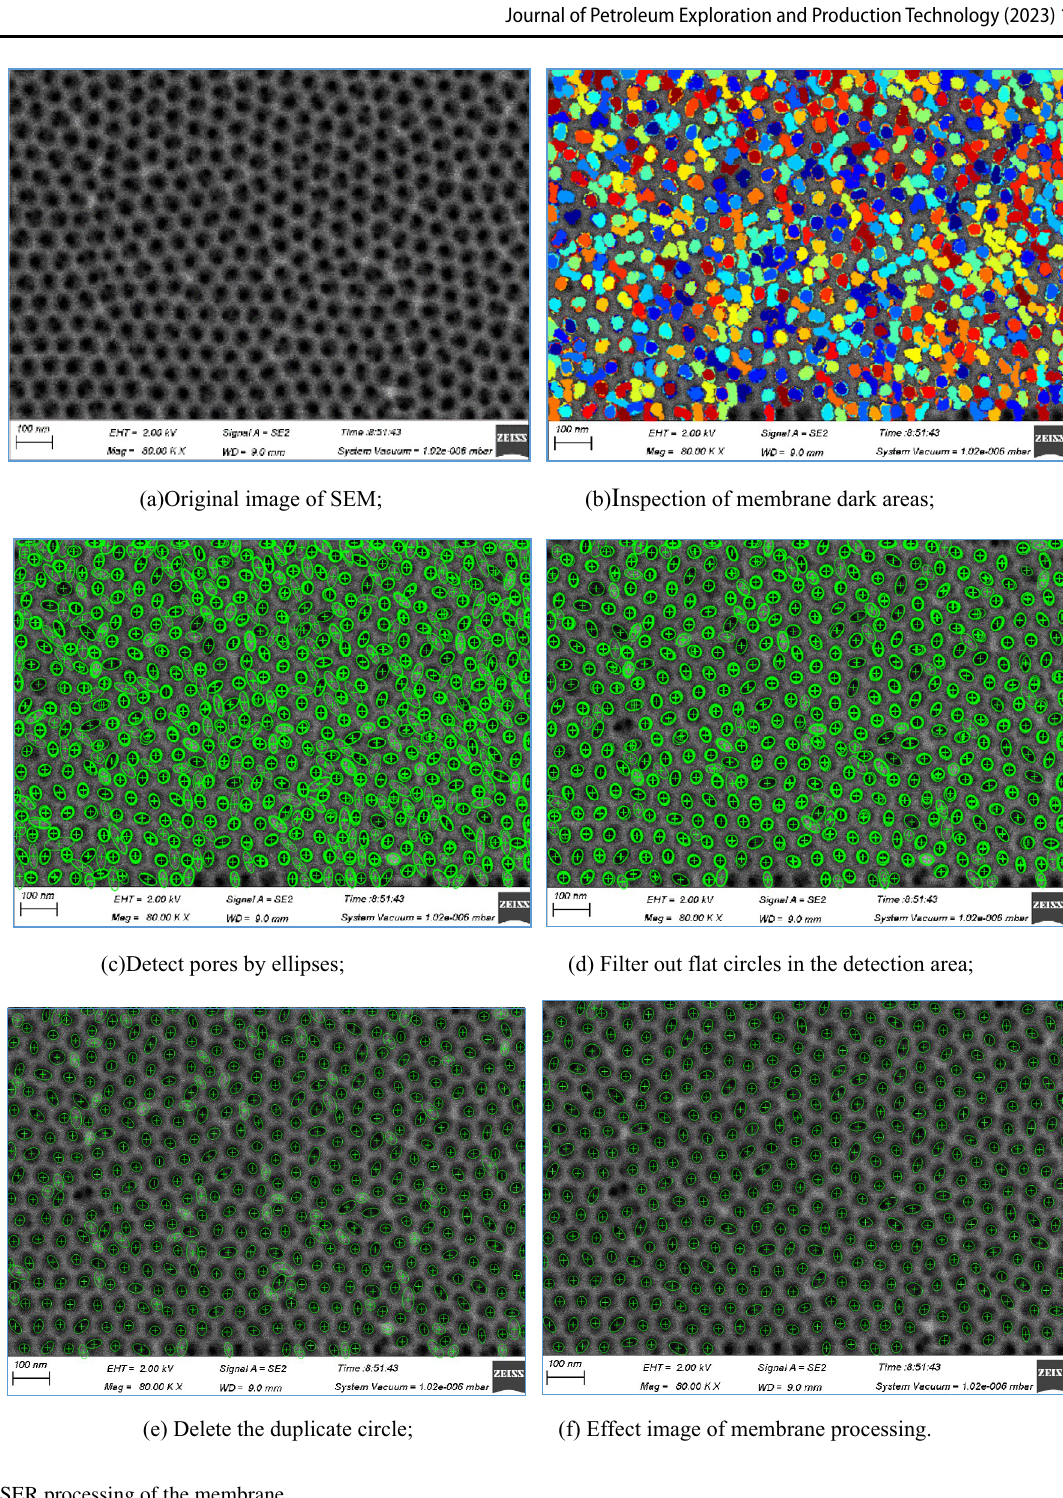
Fig. 2 MSER processing of the